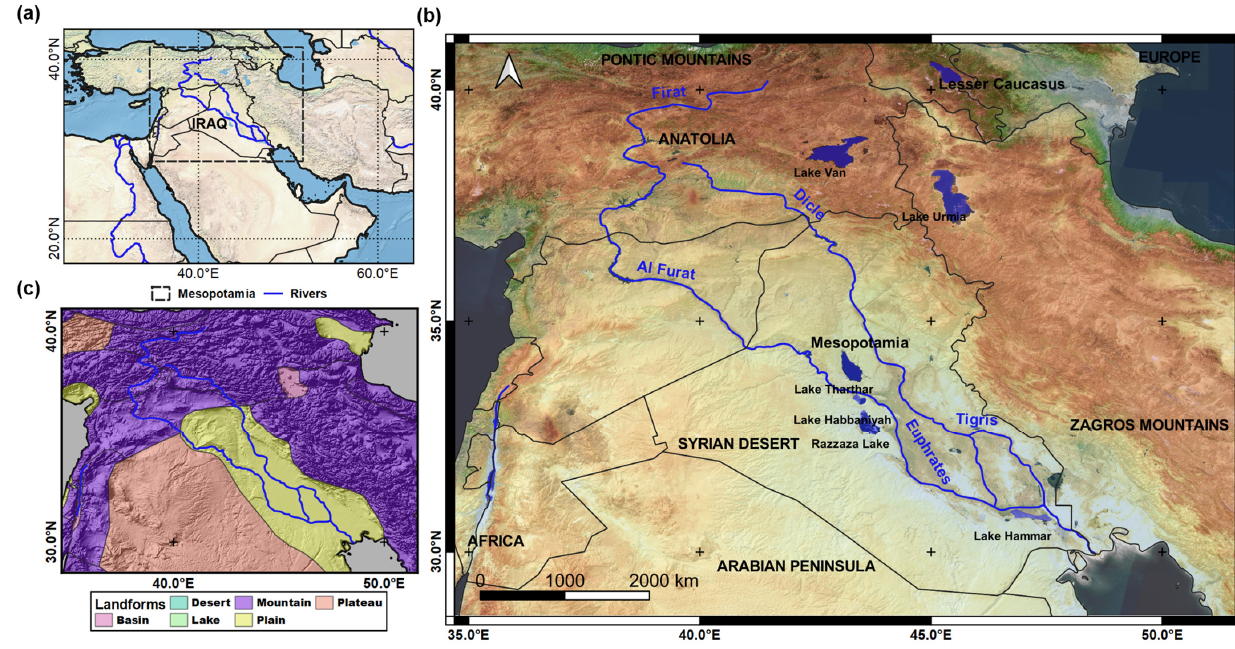
Figure 1. ( a ) The location, ( b ) geographical context of the target area, and ( c ) surrounding geomorphology (the data are available at https://esdac.jrc.ec.europa.eu/content/global-landform-classification, accessed on 1 January 2023).